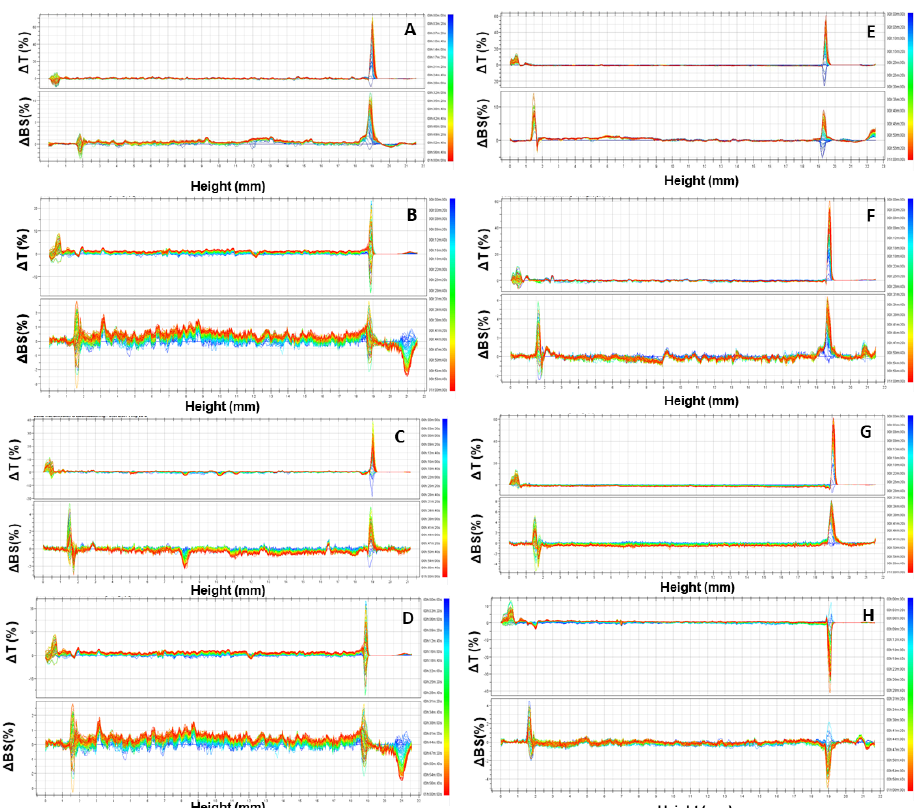
Figure 3. ΔT and ΔBS profiles of empty PLGA nanoparticles ( A , E ) and of nanosystems prepared with various amounts of URB866 [( B , F ) 0.1 mg/mL; (C,G) 0.2 mg/mL; ( D , H ) 0.4 mg/mL] using Turbiscan Lab: ( A – D ) 25 °C; ( E – H ): 37 °C. The reported result is a representative experiment of three independent experiments.